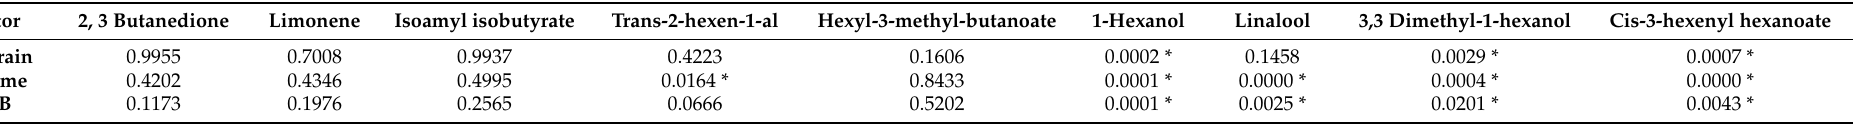
Table 4. Effect of the experimental factors (strain and time) during Habanero pepper fermentation over volatile compound concentration expressed as p